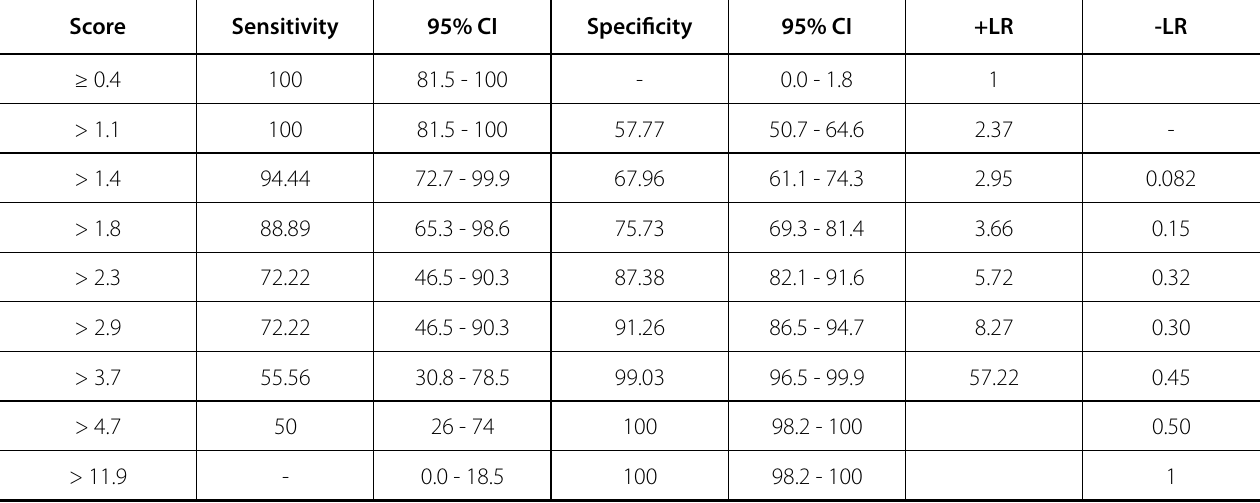
Table 1 . Best discriminatory point of the German Aortic Valve score.